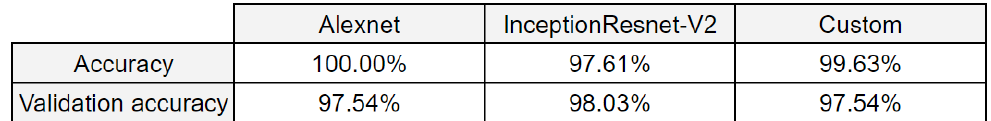
Figure 13. Comparing between Alexnet and InceptionResNetV2 CNNs for the use case of the men at sea.